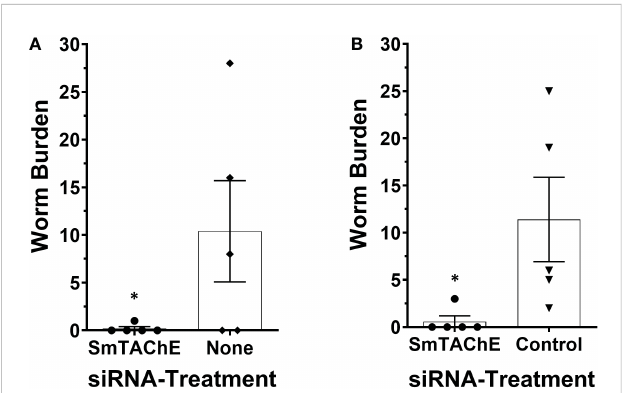
FIGURE 8 SmTAChE is essential for parasite survival in vivo . Schistosome recovery from mice 6 weeks after infection with SmTAChE- suppressed or control parasites. Results from two independent experiments are shown. (A) schistosomula were treated with siRNA speci fi c for SmTAChE, or with no siRNA, prior to infection and in (B) schistosomula were treated with siRNA speci fi c for SmTAChE or with control siRNA prior to infection. Each point represents the worm burden from one mouse, and the line represents the mean ( ± SD) for the group. In both instances, treatment with SmTAChE siRNA signi fi cantly reduced the number of recovered parasites (*P < 0.04, Students ’ t test).